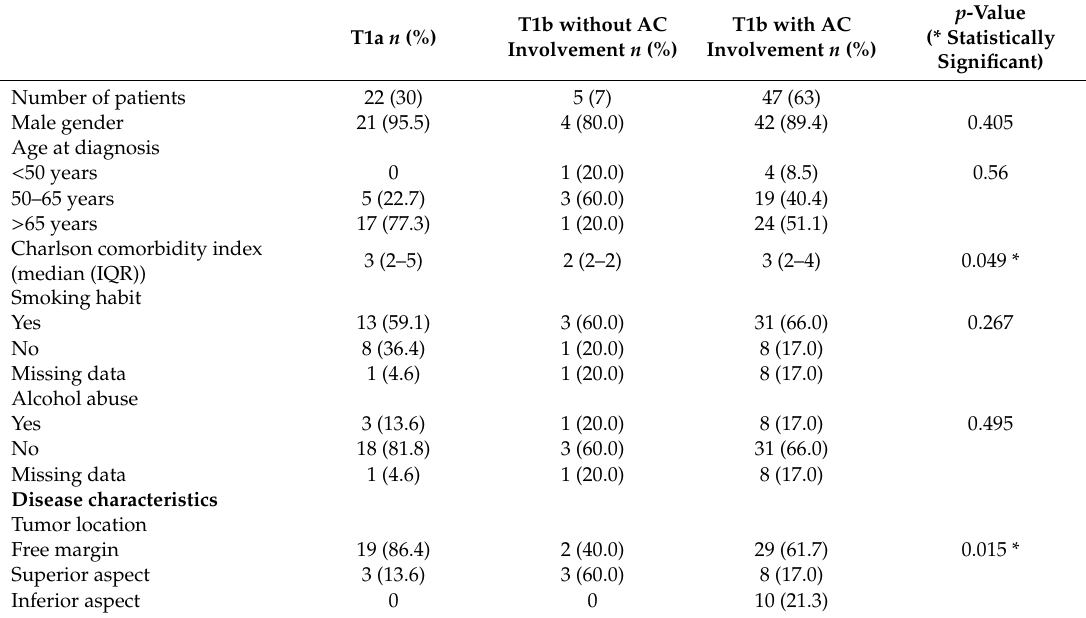
Table 1. Study population